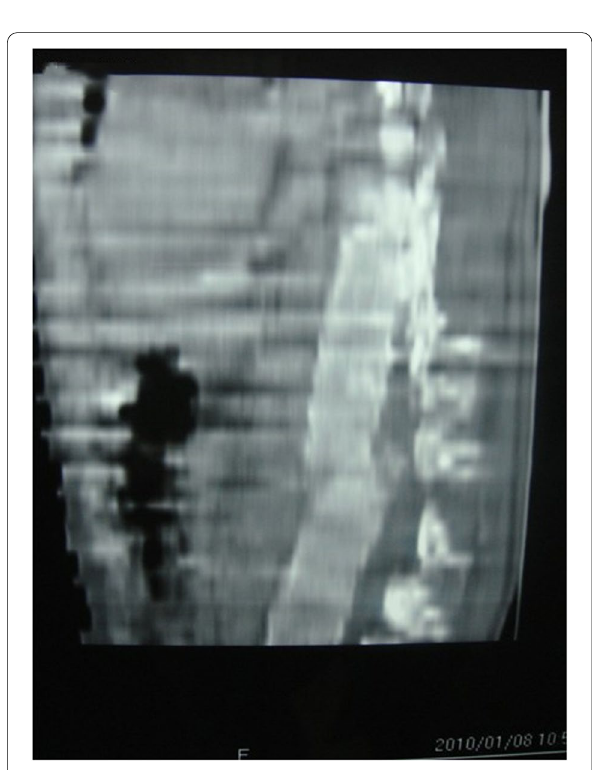
Fig. 12 Spine CT scan in case 2 showing vertebral